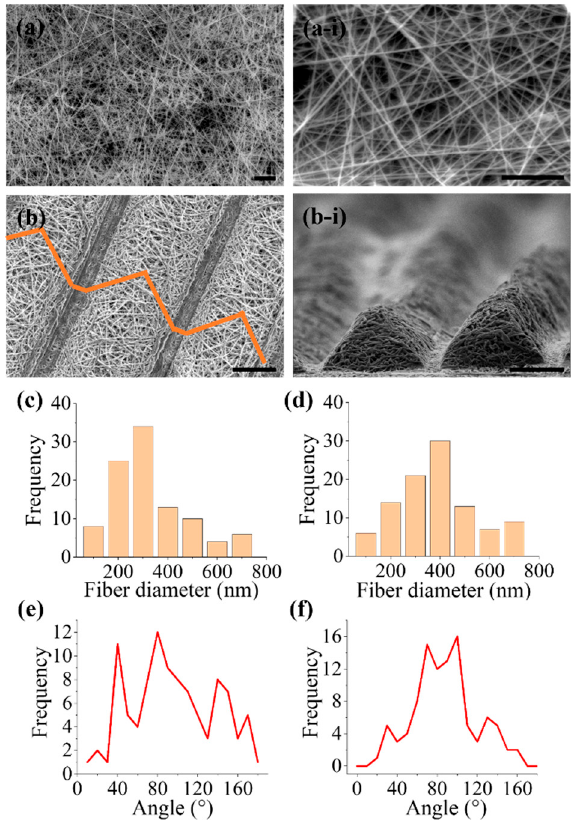
Figure 3. Scanning electron microscope (SEM) images of ( a , a-i ) 2D scaffold in random orientation, ( b ) structural scaffold at the top view and ( b-i ) structural scaffold at the side view. Fiber diameter distribution for ( c ) 2D scaffold and ( d ) structural scaffold. Fiber orientation distribution for ( e ) 2D scaffold and ( f ) structural scaffold. The scale bar for ( a , a-i ) represents 10 µm and 5 µm, respectively. The scale bar for both ( b ) and ( b-i ) represents 50 µm.